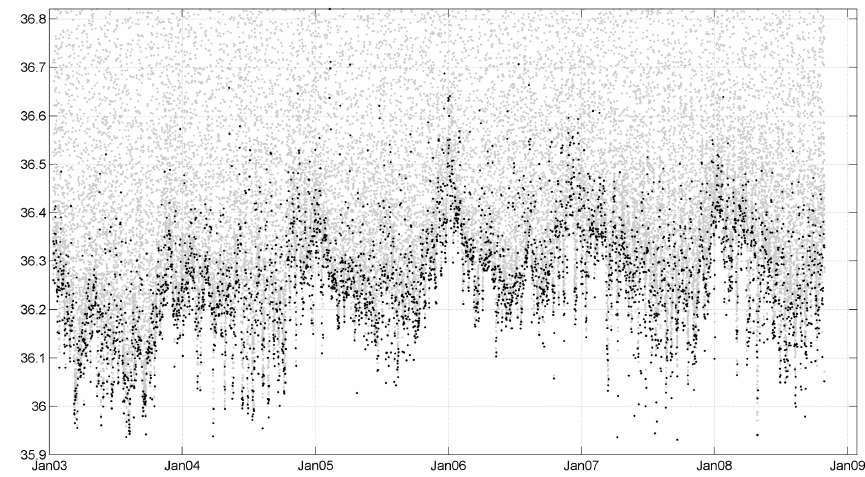
Fig. 3. S time series of the AW (at 80m) on the MS (west of Gibraltar). The black dots represent the lowest S value during each semi-diurnal (12h)